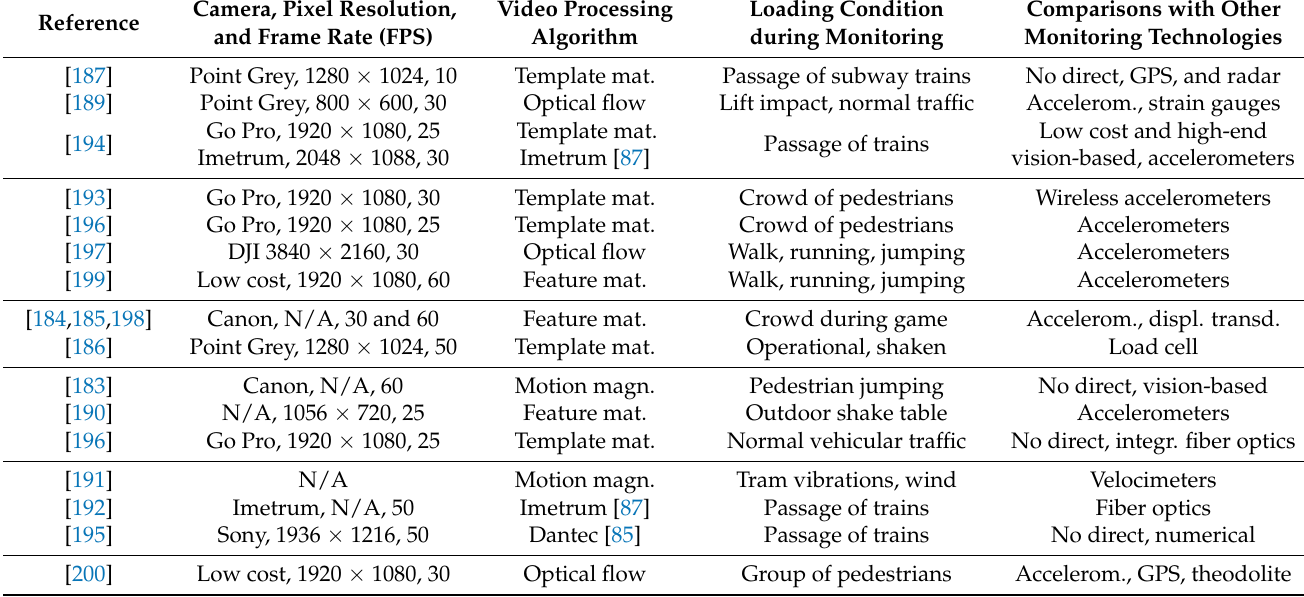
Table 2. Essential information on adopted hardware, video processing, loading conditions during monitoring, and comparison with other monitoring technologies.